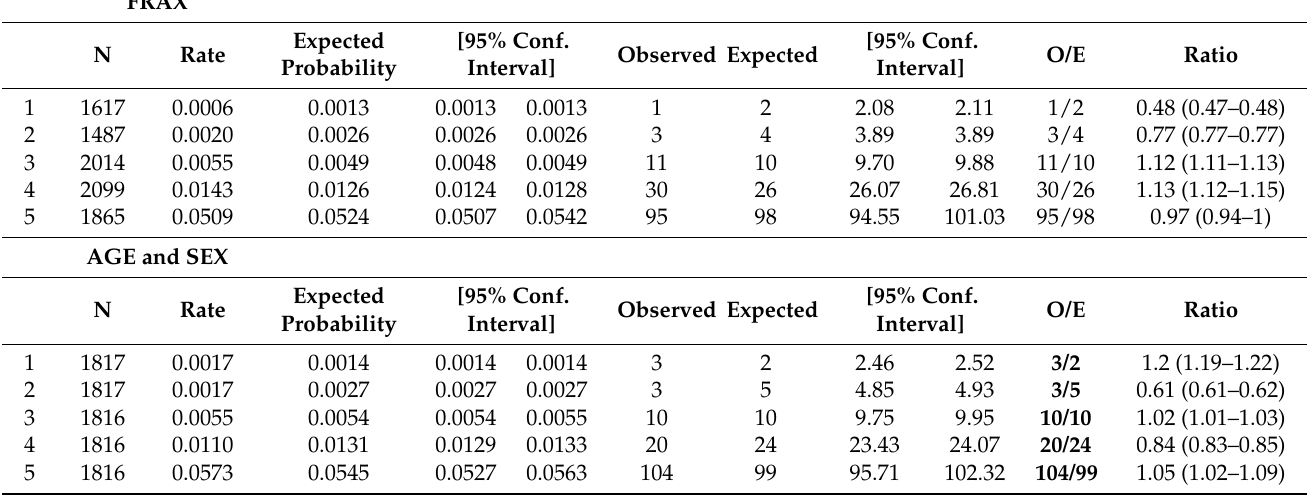
Table 2. Calibration of observed versus predicted hip fracture by FRAX and the age and sex model by quintiles of